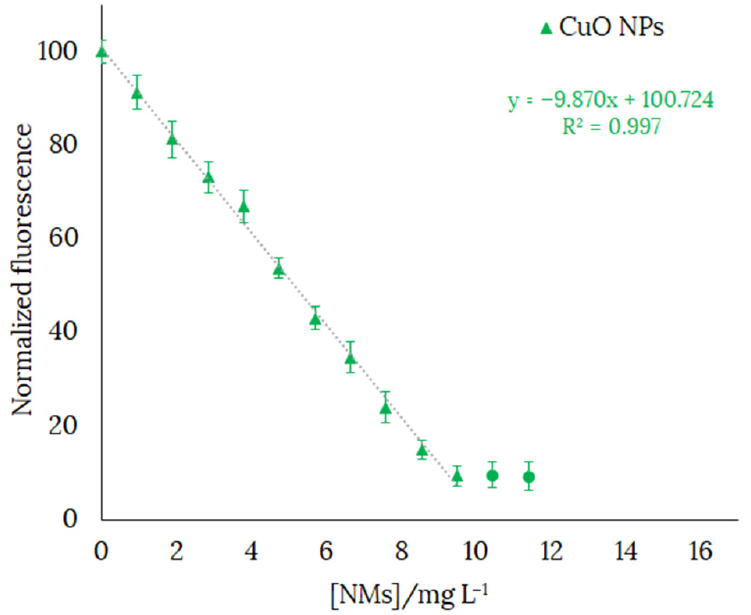
Figure 13. Fluorescence emission spectra calibration curve of H 3 L in 80:20 ethanol:water solution at pH 11, with gradual addition of CuO NPs (until the fluorescence intensity stops decreasing). [H 3 L] = 126 ppb. NaOH 0.1 M was used to deprotonate H 3 L. Final volume of the solution = 4 mL. Each solution was sonicated for 1 min before being measured. λ exc = 400 nm.